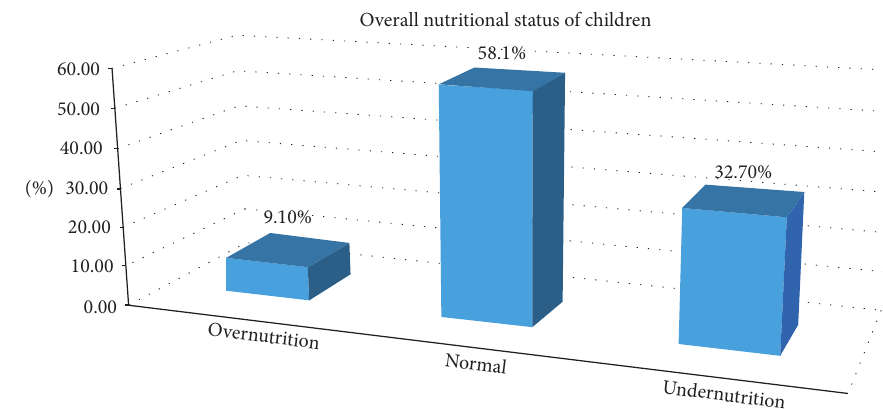
Figure 1: The nutritional status of primary school students in Gondar town,